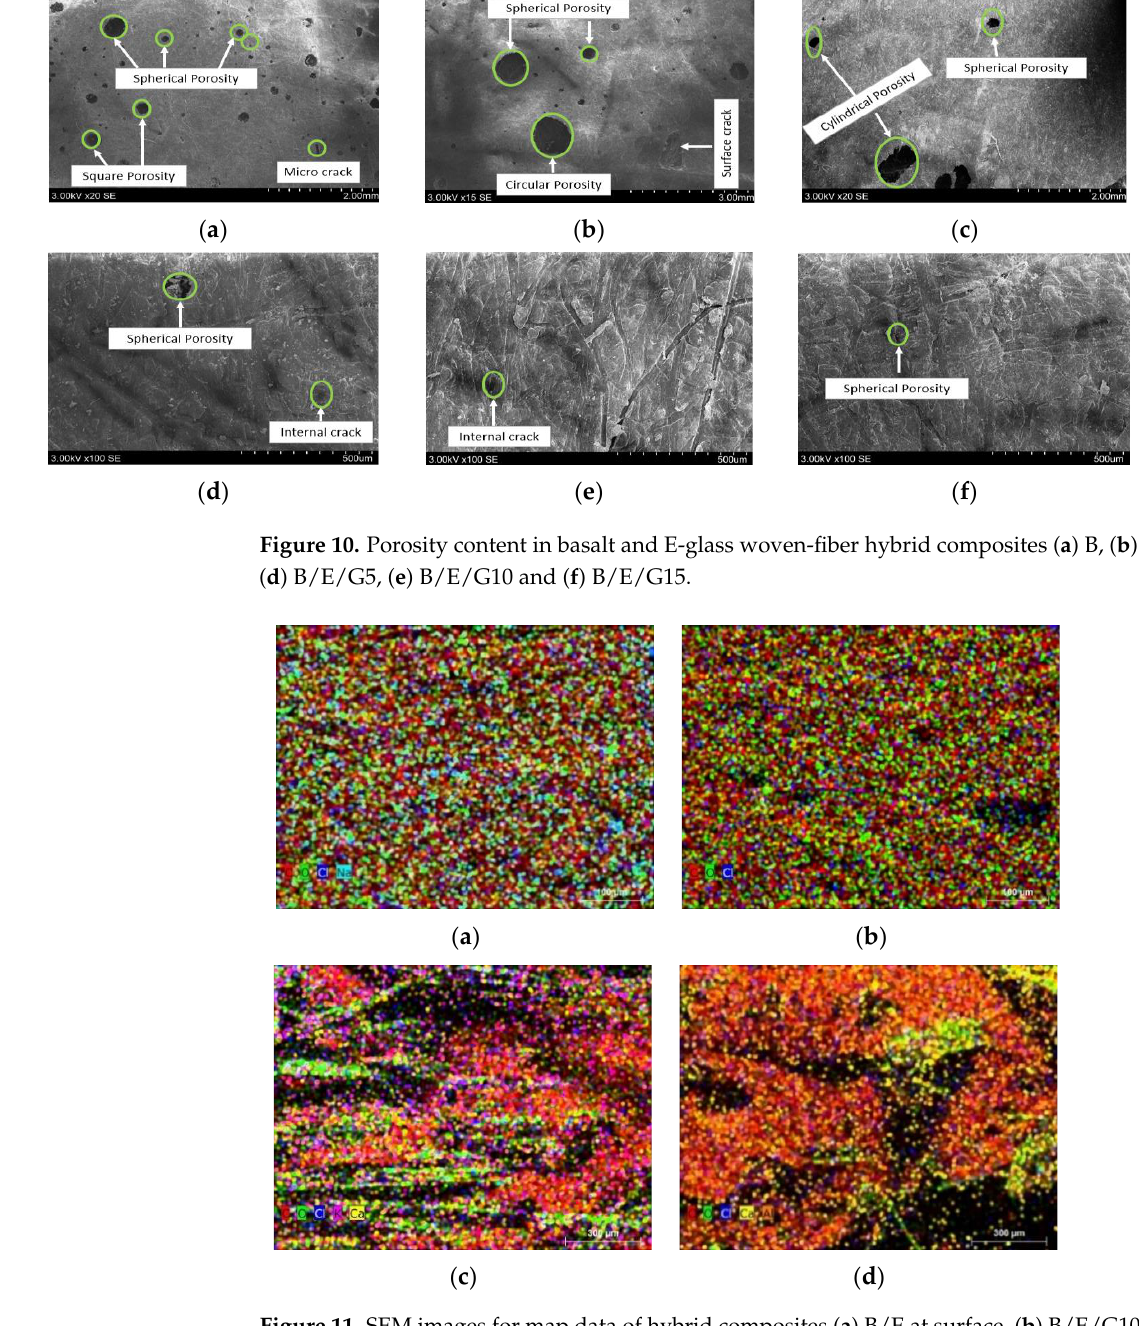
Figure 10. Porosity content in basalt and E-glass woven-fiber hybrid composites ( a ) B, ( b ) E, ( c ) B/E, ( d ) B/E/G5, ( e ) B/E/G10 and ( f ) B/E/G15.